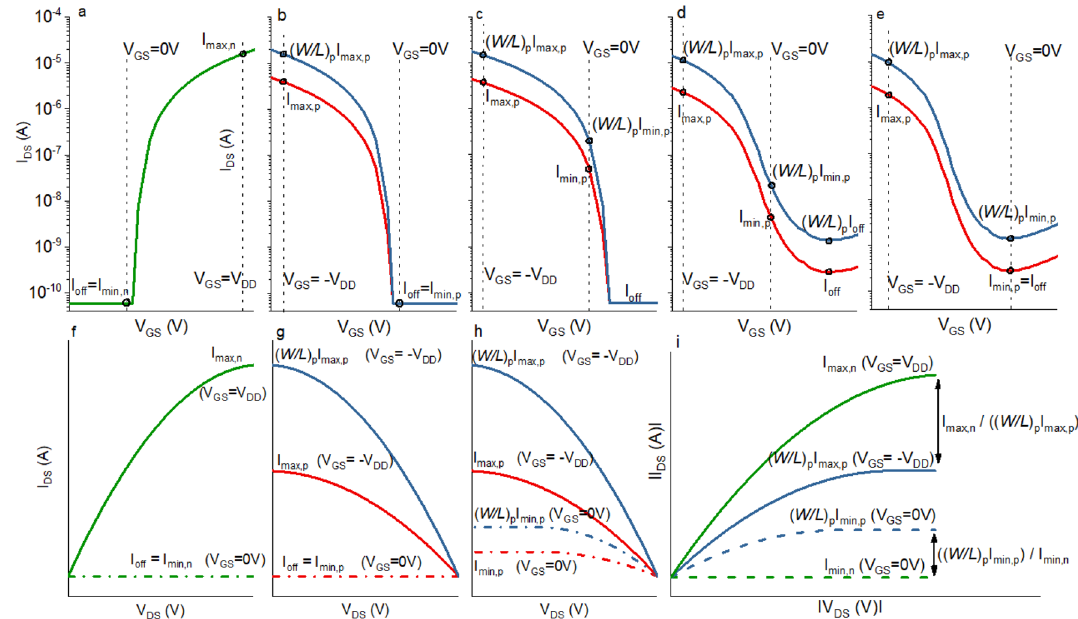
Figure 1. Transfer characteristics and output characteristics of: ( a , f ) ‘ideal silicon’ n-type transistor with V on ~ 0 V and complete channel depletion; I off = I min,n does not scale with ( W/L ) n . ( b , g ) p-type transistor with V on ~ 0 V and complete channel depletion; to match the higher mobility of the n-type, I max,p is scaled by ( W/L ) p, I off = I min,p does not scale with ( W/L ) p . ( c , h ) p-type transistor with V on > 0 V and complete channel depletion; at V GS = 0 V the transistor is partly turned on and both I max,p and I min,p scale with ( W/L ) p . ( d , e , h ) ‘oxide’ p-type transistor without complete channel depletion; both I off and I min,p scale with ( W/L ) p . ( i ) Maximum and minimum output currents for n- (green) and p-type transistors, and the ratio between them after scaling with ( W/L ) p